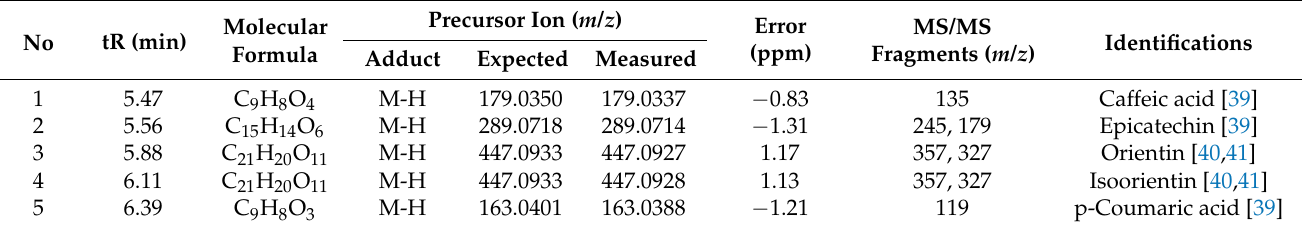
Table 1. Identification of phytochemicals in VBT via UHPLC-UV-HRMS.